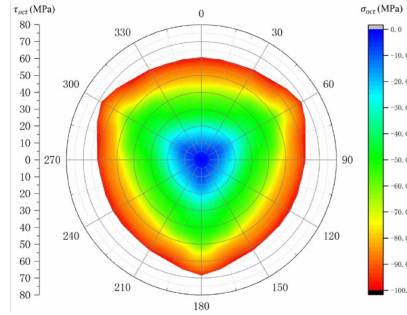
Figure 9. Deviatoric plane of the RF model.